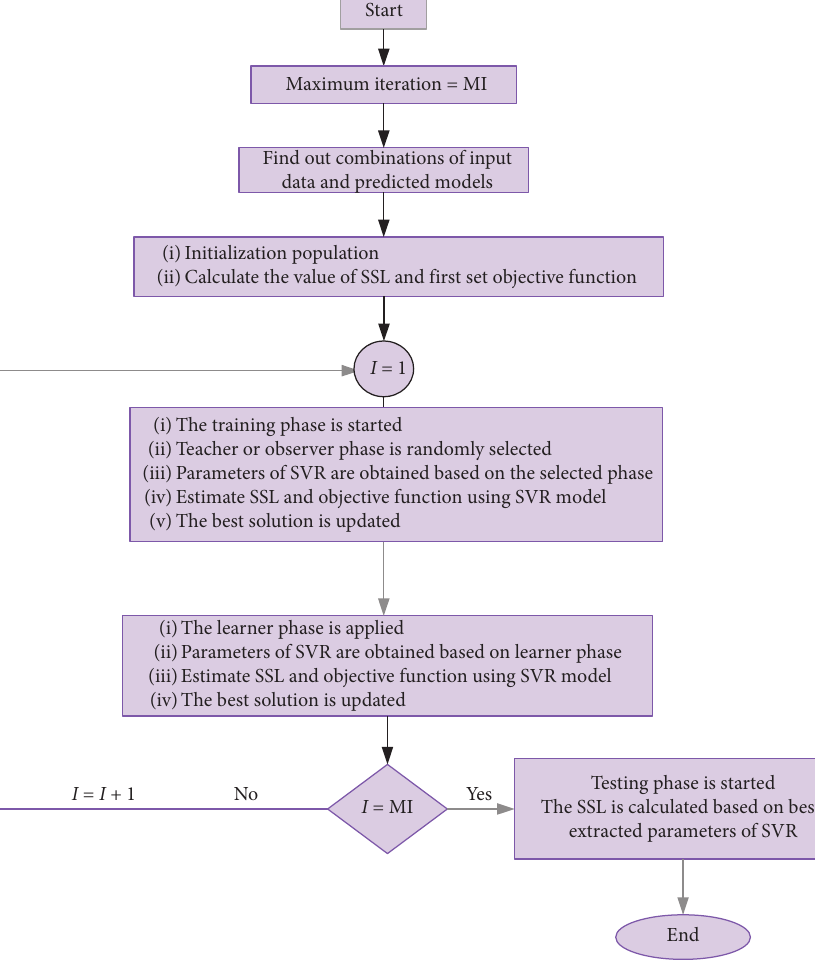
Figure 2: Algorithm of the SVR-OTLBO